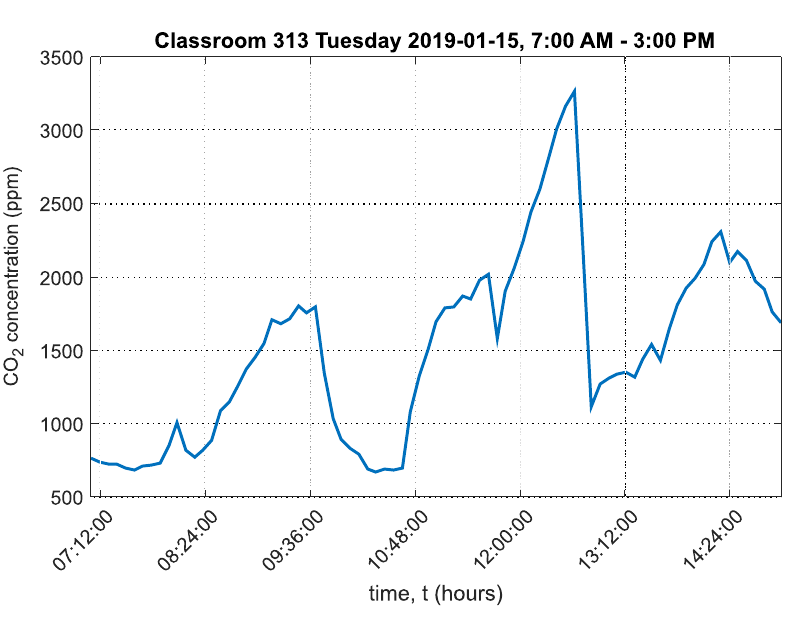
Figure 21. Graph of carbon dioxide concentration in classroom 313, Frenštát pod